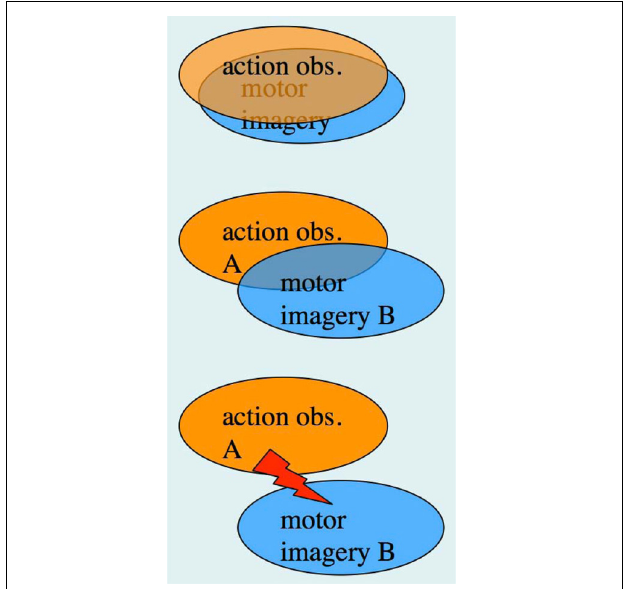
FIGURE 3 | The spectrum of concurrent AO + MI states. Top panel: congruent AO + MI; Center panel: coordinative AO + MI, where two different actions A and B are co-represented in some form; Bottom panel: conflicting AO + MI (see text for